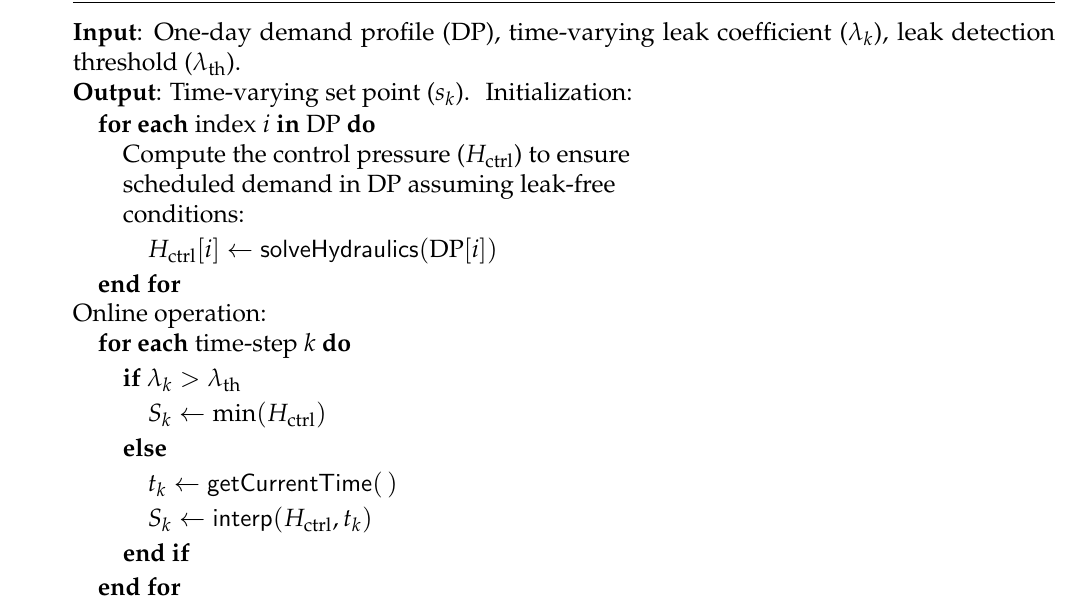
Algorithm 1: Set point manager for pressure